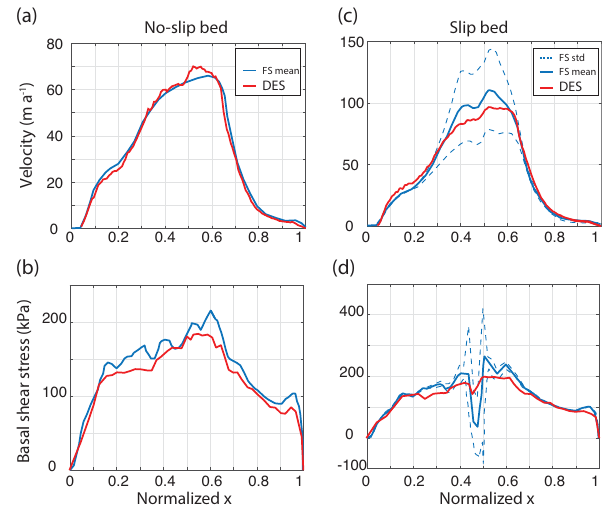
Figure B1. DES with semi-brittle ice executed according to ex- periment E presented by Pattyn et al. (2008). (a) Surface velocity and (b) basal shear stress for ice completely frozen to the bed, and (c) surface velocity and (d) basal shear stress for ice with a freely slipping patch for a small portion of the domain. Full stokes (FS, blue line) model means compare reasonably with those from DES (red